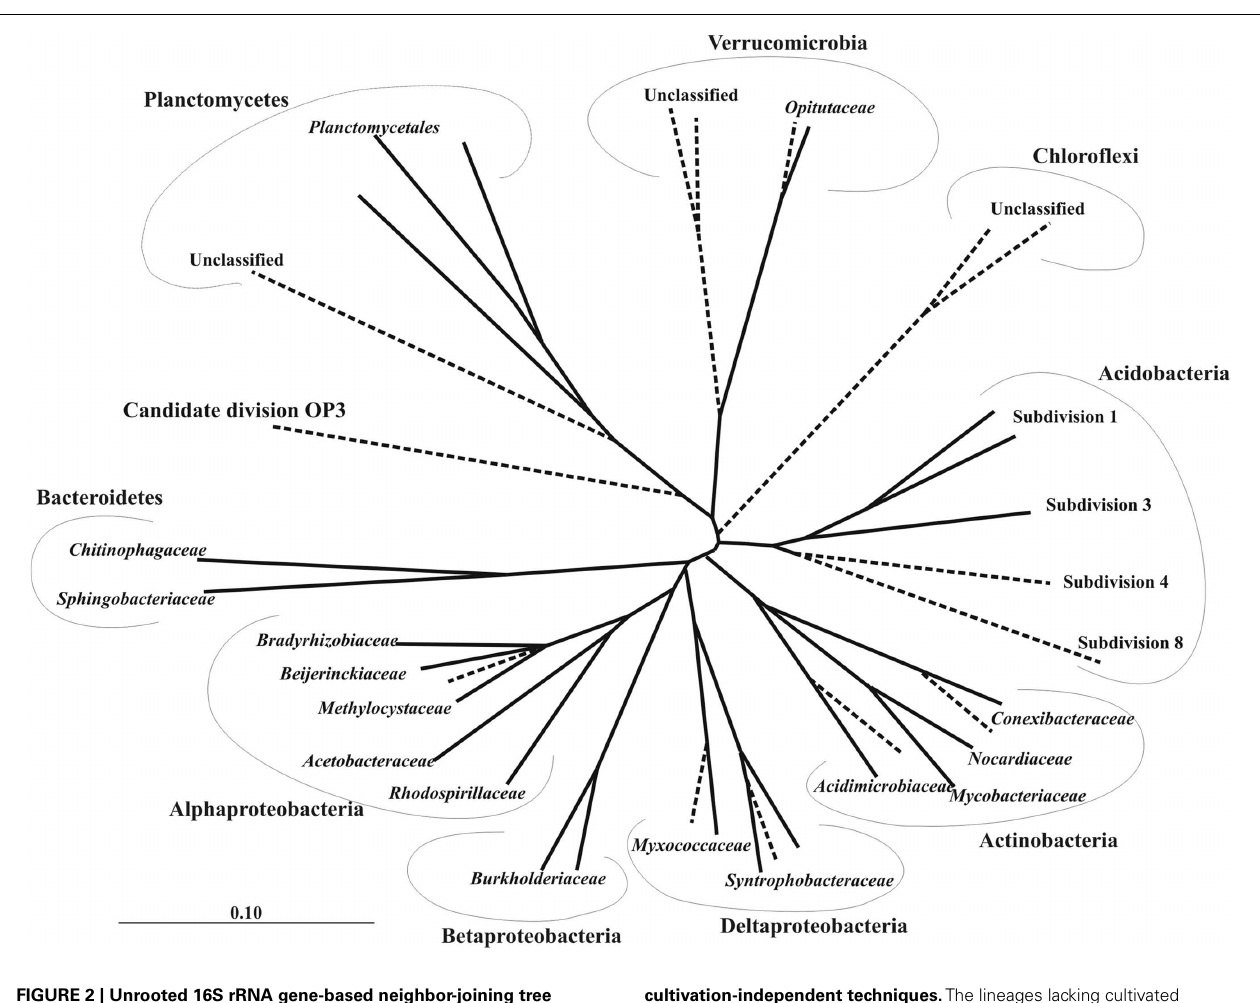
FIGURE 2 | Unrooted 16S rRNA gene-based neighbor-joining tree showing the major phylogenetic lineages of bacteria that have been detected in Sphagnum -dominated wetlands by means of